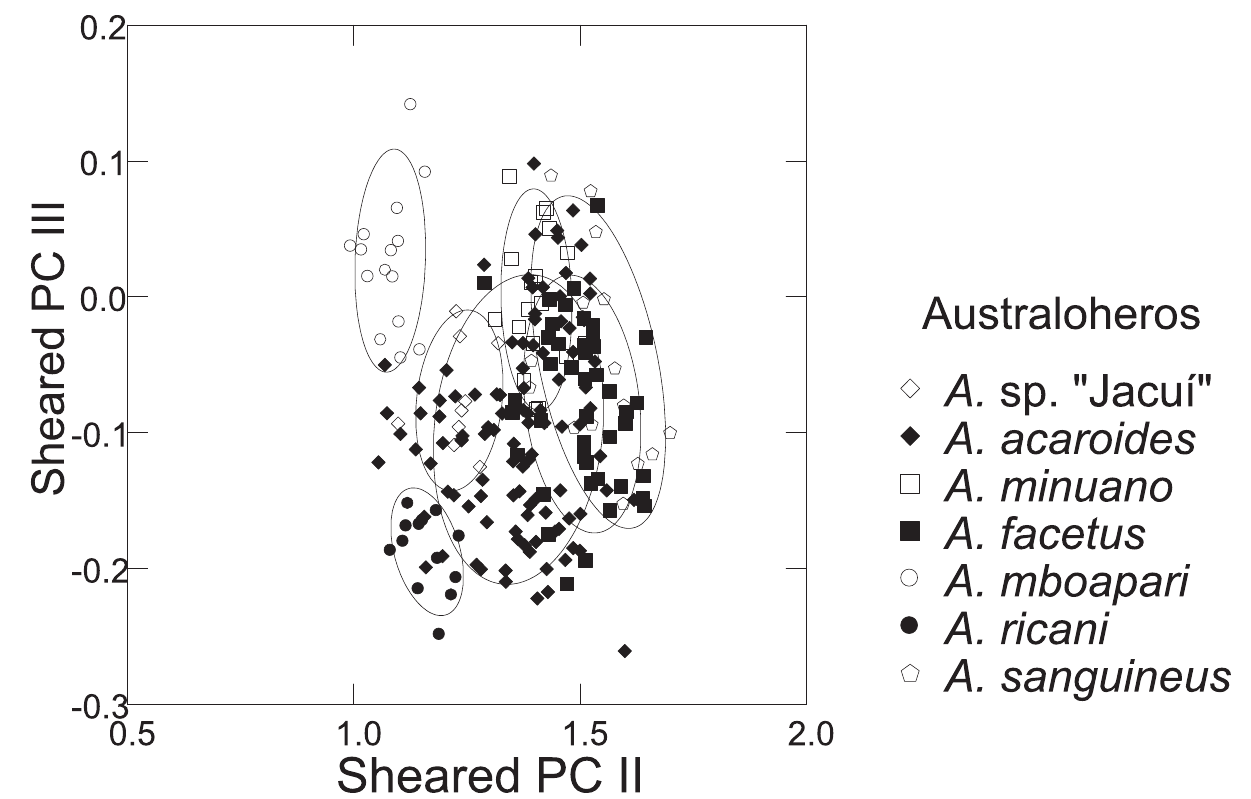
Fig 9. Plot of scores of PC II on PC III from PCA of 13 distance measurements from pooled specimens of Australoheros from the Rio Jacuı´basin ( A . acaroides , A . facetus , A . mboapari , A . ricani , and A . sp. “Jacuı´.”.